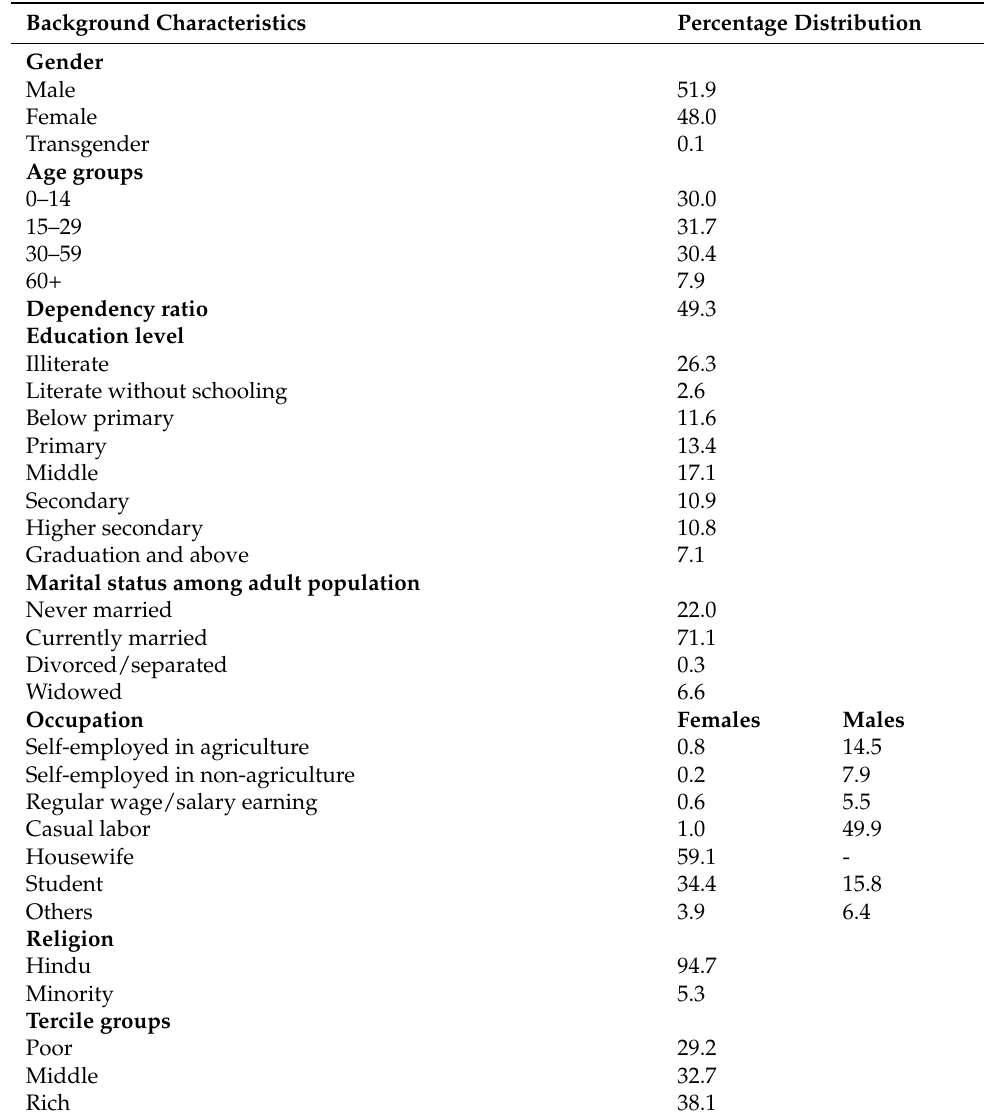
Table 1. Socio-demographic profile of the population in the study area ( n = 120,306). Background